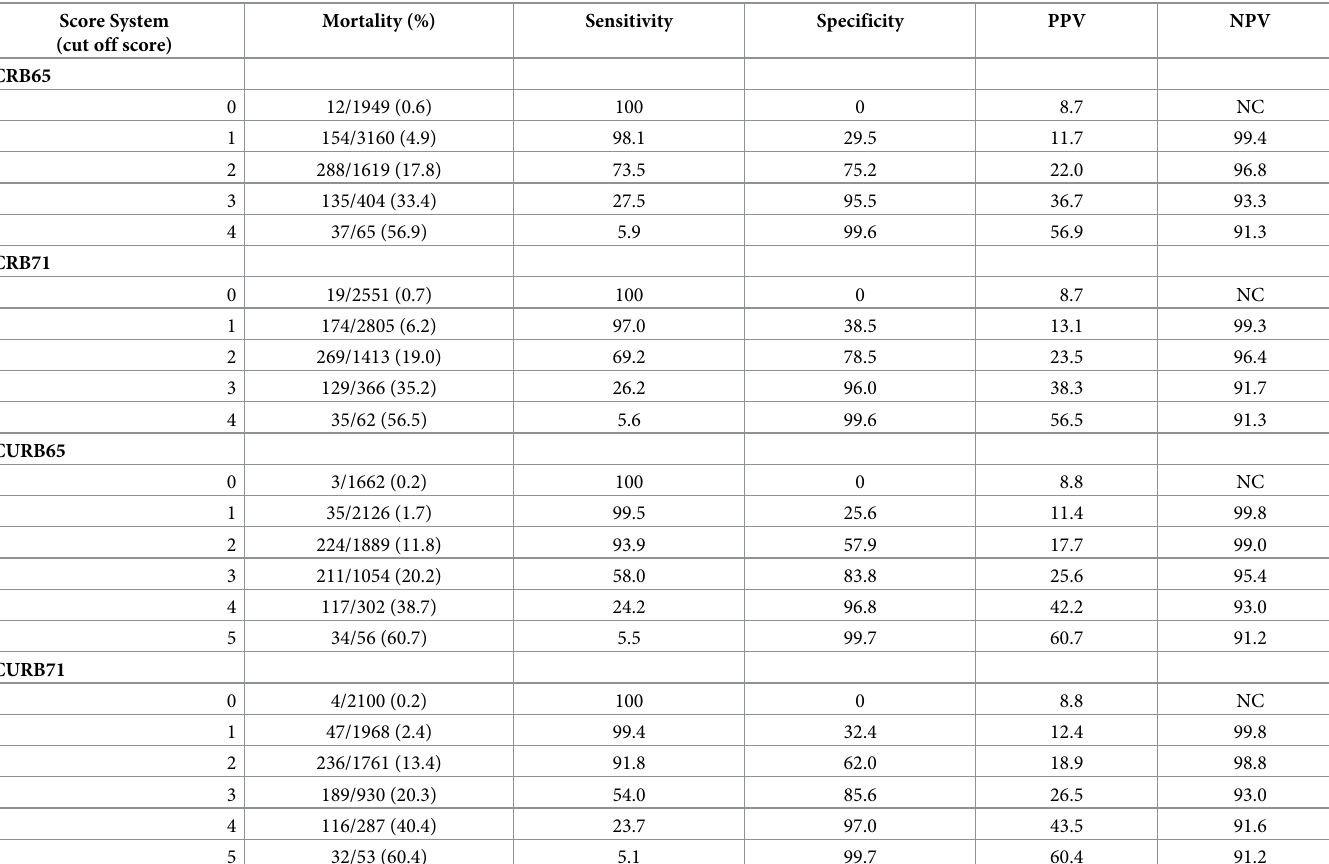
Table 3. Relationship between increasing the cut-off age and risk of mortality of patients from SNUBH-EDP registry. Score System (cut off